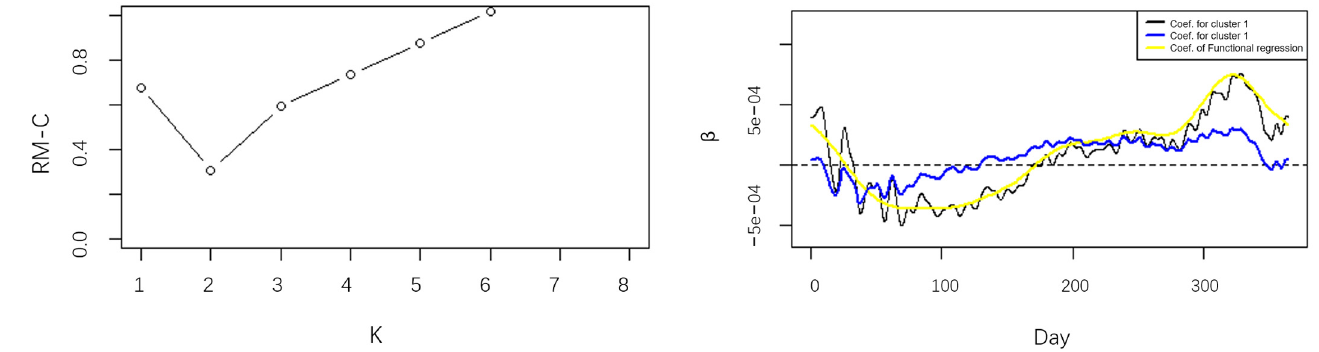
Figure 3. RM-C values over the candidate 𝐾 (the left panel) and coefficients for both the pooled data and the clustered data (the right panel).